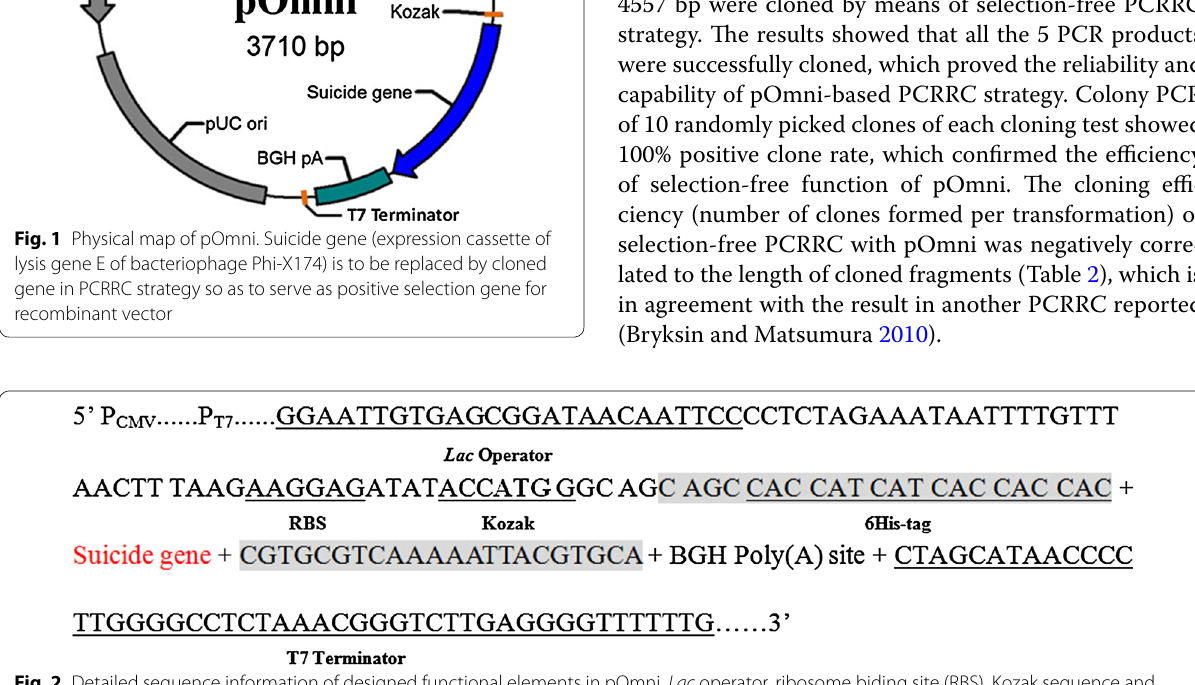
Fig. 2 Detailed sequence information of designed functional elements in pOmni. Lac operator, ribosome biding site (RBS), Kozak sequence and 6His tag were introduced between T7 promoter and BGH Poly(A) site. PCR amplified target gene products containing two primer-introduced termi- nal sequences ( shaded sequences ) can be directionally and seamlessly inserted into correspondent position and replace the suicide gene through recombination PCR. The designed Kozak sequence and its proper position related to RBS make it possible to express cloned target gene in both E. coli and eukaryotic